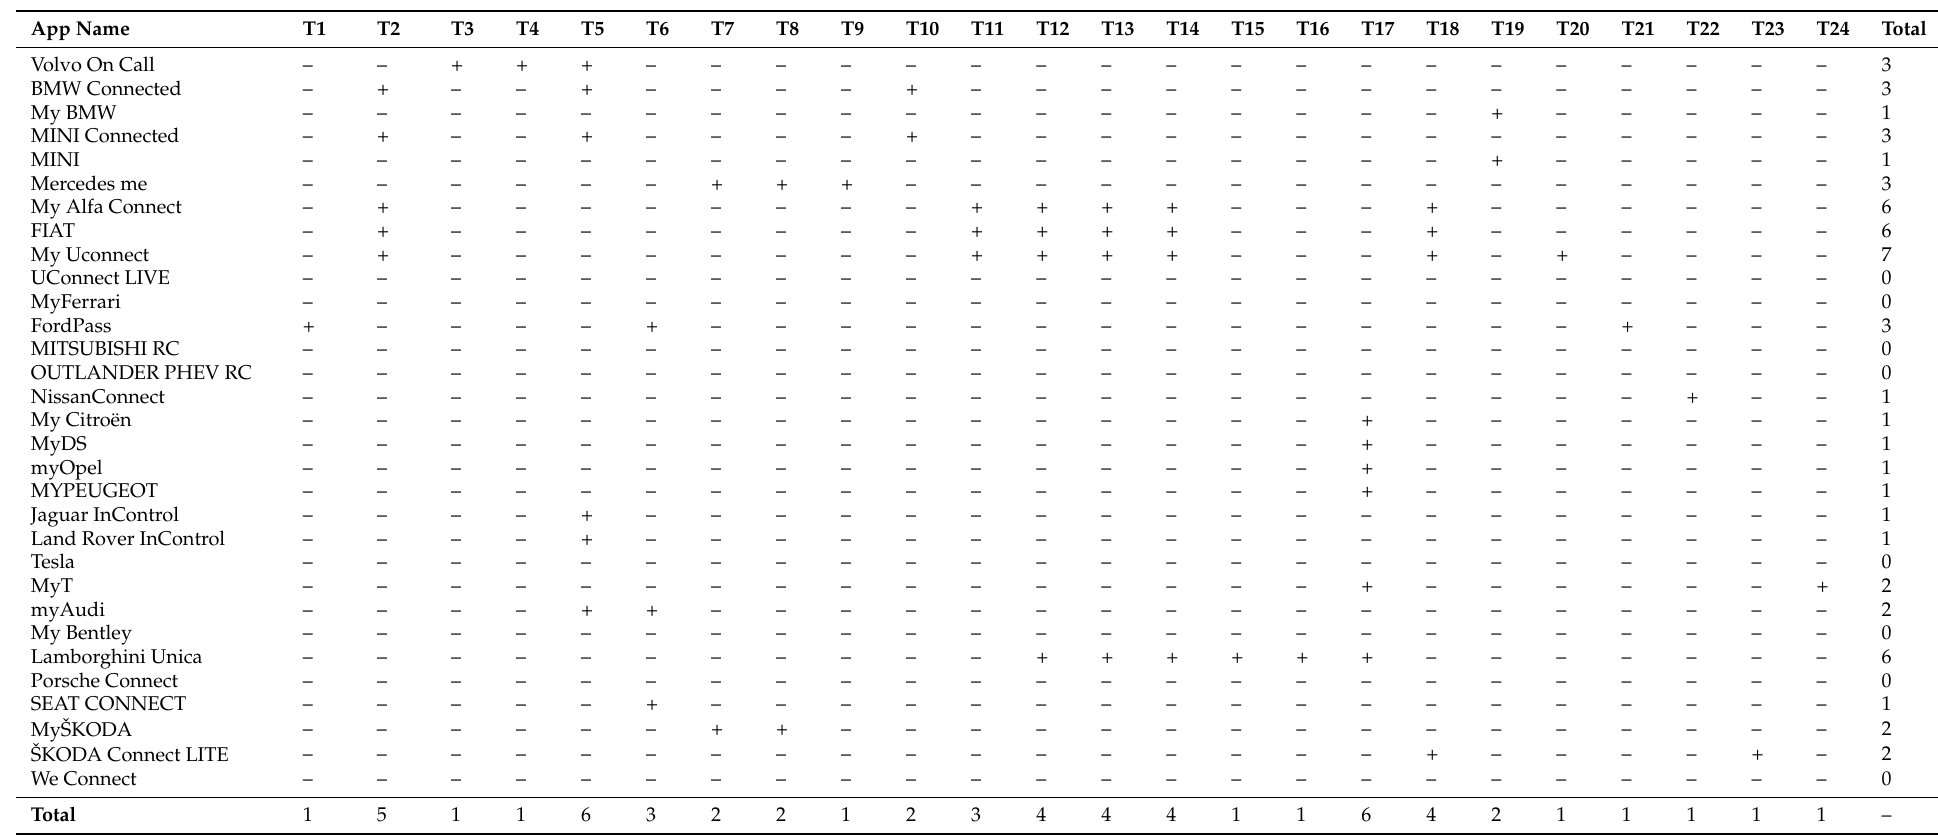
Table 6. Third-party trackers per